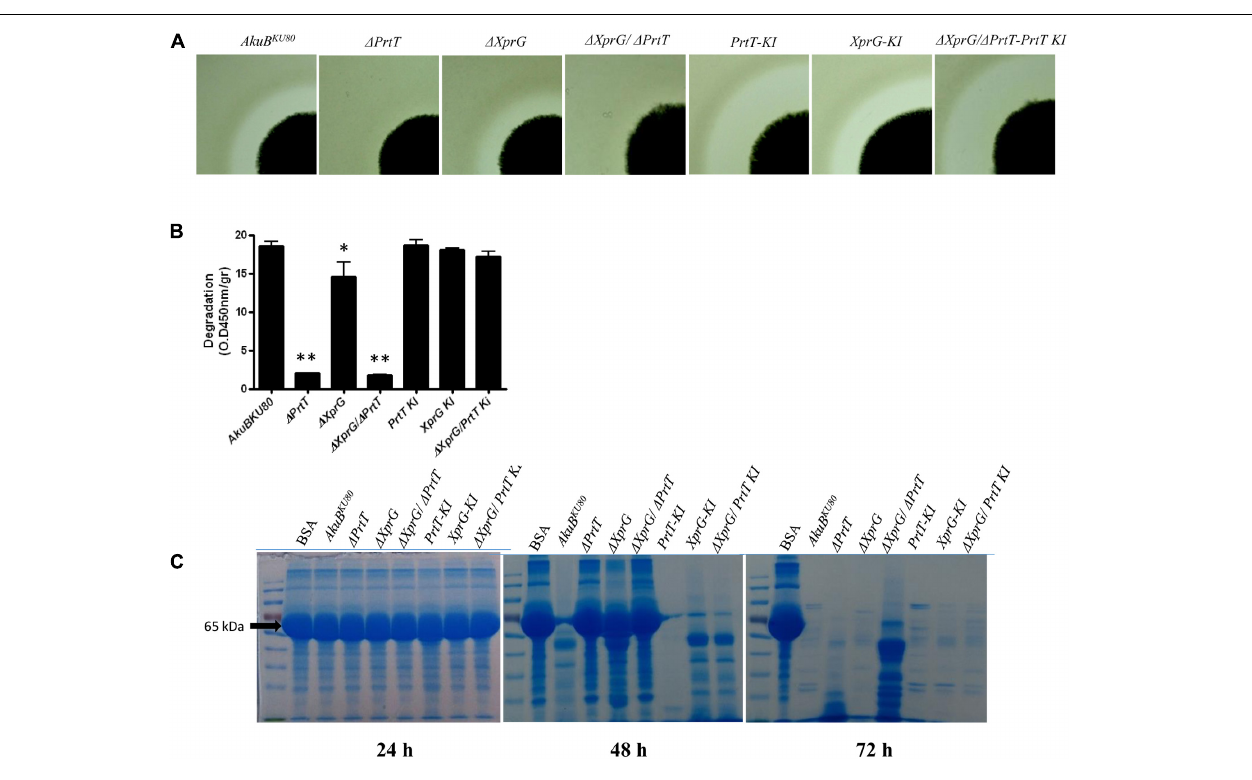
FIGURE 3 | Proteolytic activity following deletion of prtT and xprG . Proteolytic activity of the fungal strains was assessed by (A) Halo formation on SM agar plates containing 0.1% Tween 20 following 48 h of growth at 37 ◦ C followed by another 48 h at room temperature. (B) Degradation of azocasein by A. fumigatus culture filtrates (CFs). The absorbance of the released azo dye was measured spectrophotometrically at 450 nm. ( ∗ P < 0.05, ∗∗ P < 0.0001). (C) BSA proteolysis by A. fumigatus CFs followed by SDS-PAGE analysis of the cleaved substrate. BSA (65 kDa, arrow) and other proteins were stained by